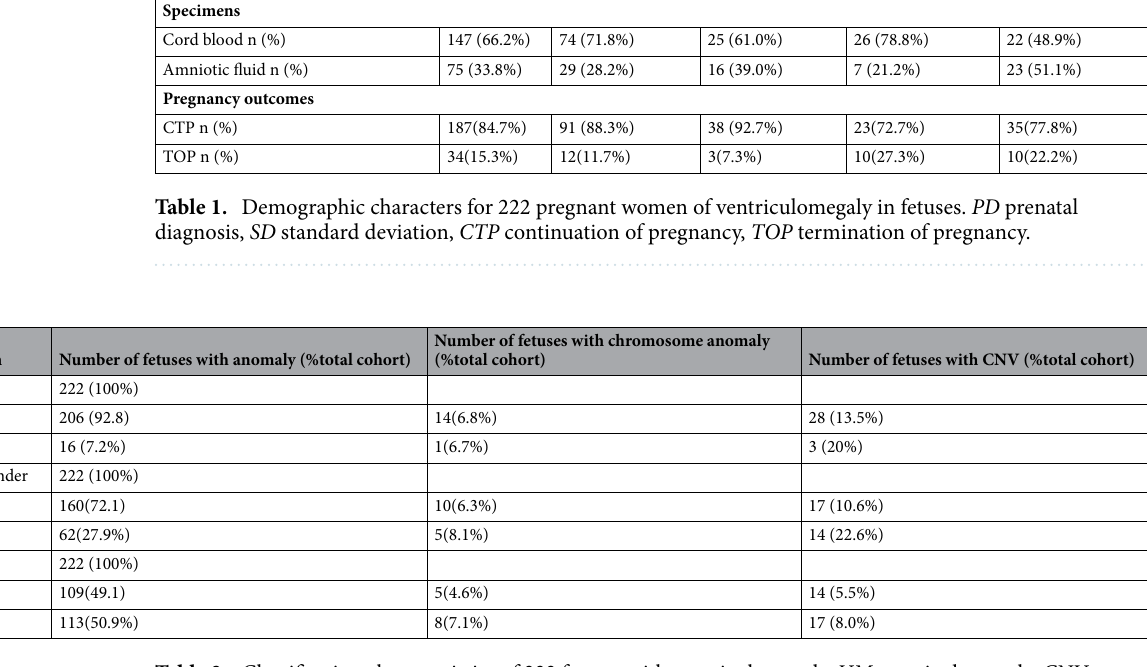
Table 2. Classification characteristics of 222 fetuses with ventriculomegaly. VM ventriculomegaly, CNV copy number variation.